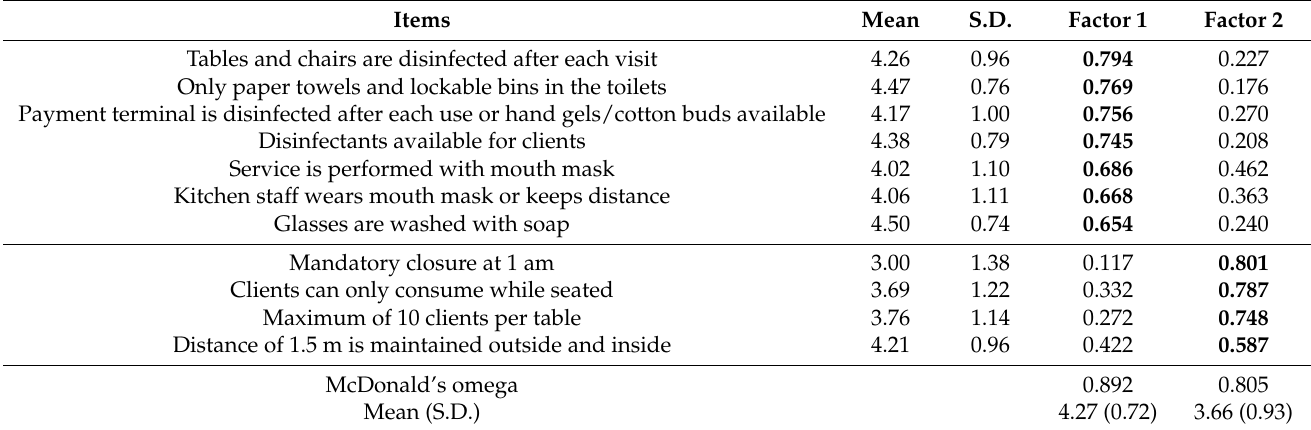
Table 5. Factor loadings from principal component analysis for consumers’ attitudes towards imposed safety measures (study 2; n = 309 ).